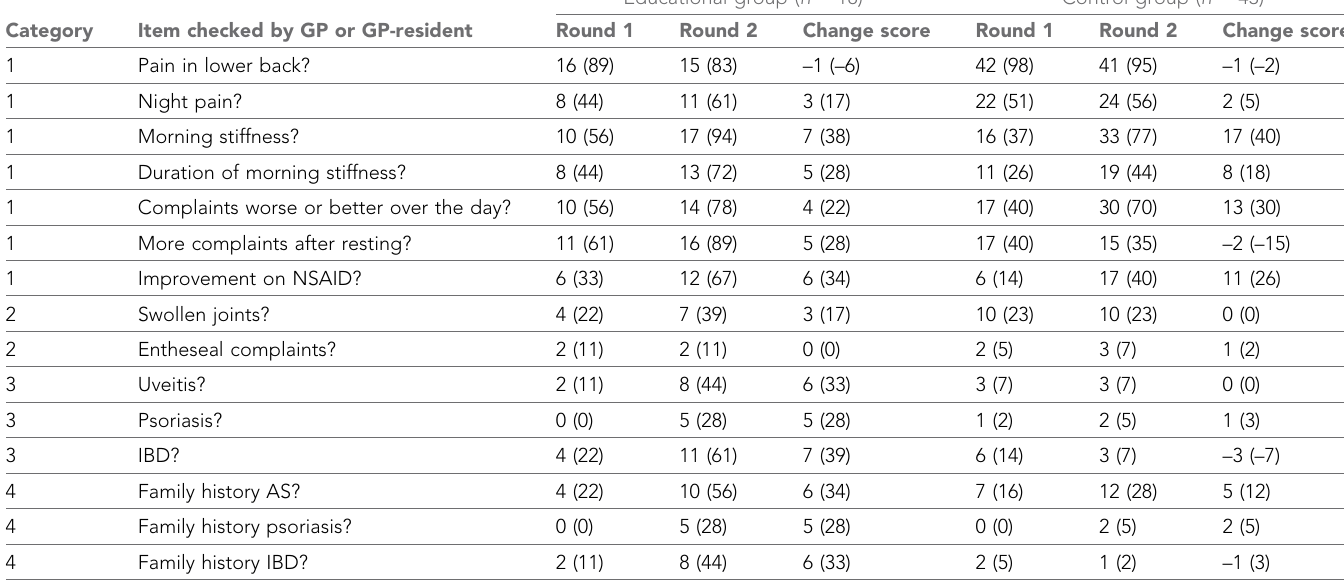
Table 1. Pattern of history taking of GP(-residents) facing a patient with axial SpA in round 1 and 2